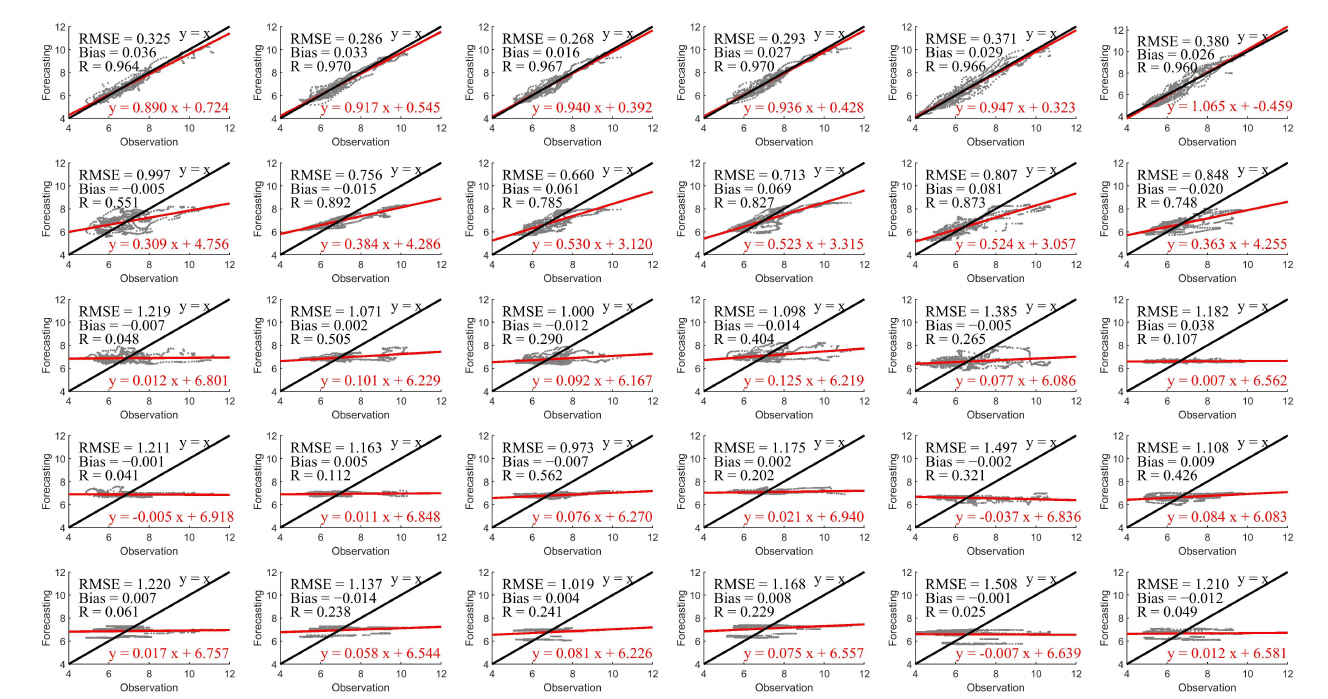
Figure 4. Scatterplots of observation and forecasting obtained in different experiments using the Conv-GRU model with a 6-h lead time. The subplots from top to bottom represent the first five experiments in Table 3, respectively. The subplots from left to right correspond to P1 to P6. The red line indicates a linear fit and the black line means a full correlation.